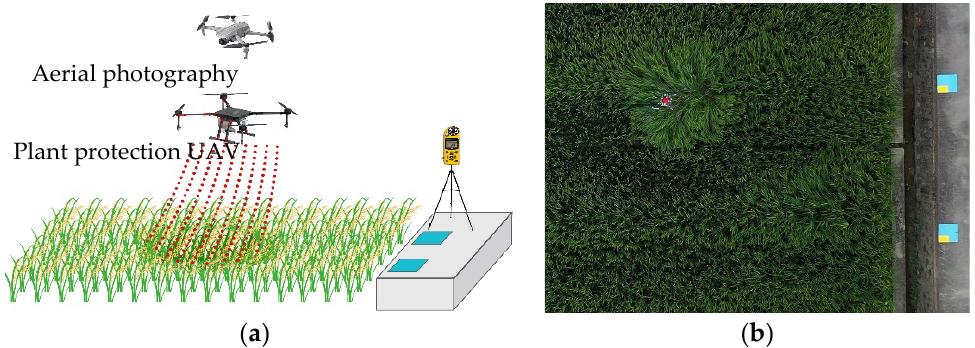
Figure 2. Experimental process and method of recording wind-vortex image. ( a ) Experimental method. ( b ) Aerial imagery.